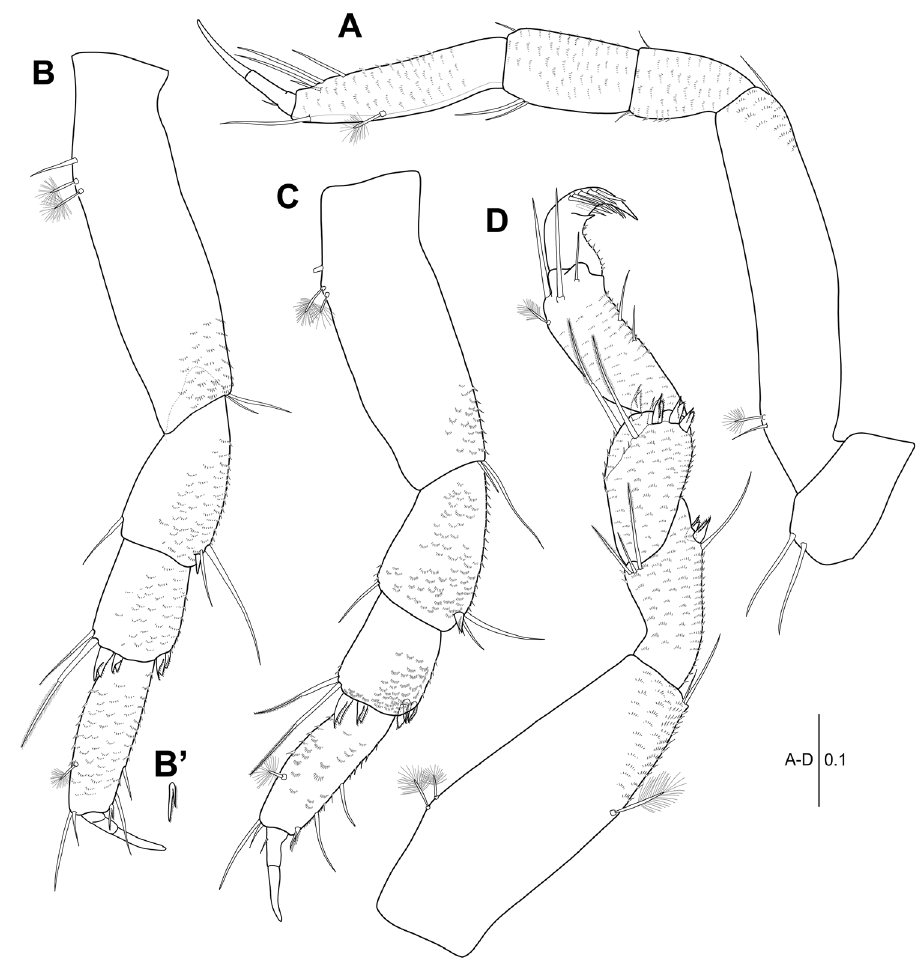
Figure 3. Hexapleomera ulsana sp. n., female holotype, A pereopod 1 B pereopod 2 C pereopod 3 D pereopod 4. Scale bars in